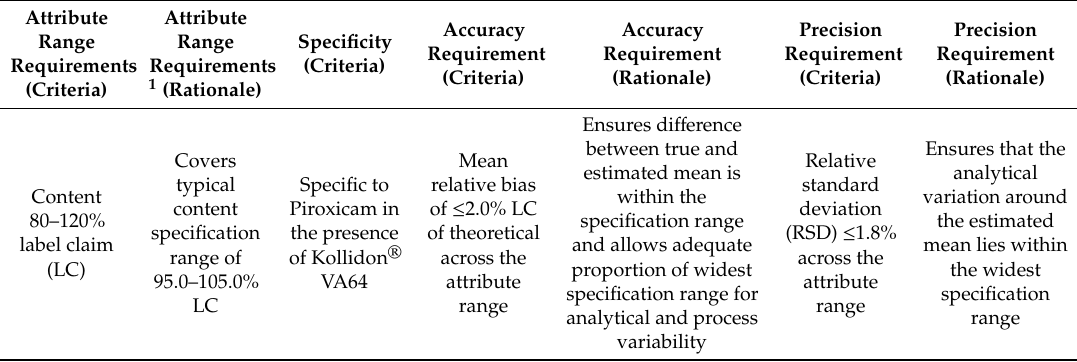
Table 1. Analytical target profile (ATP) to determine the content of piroxicam (PRX) in Kollidon ® VA 64